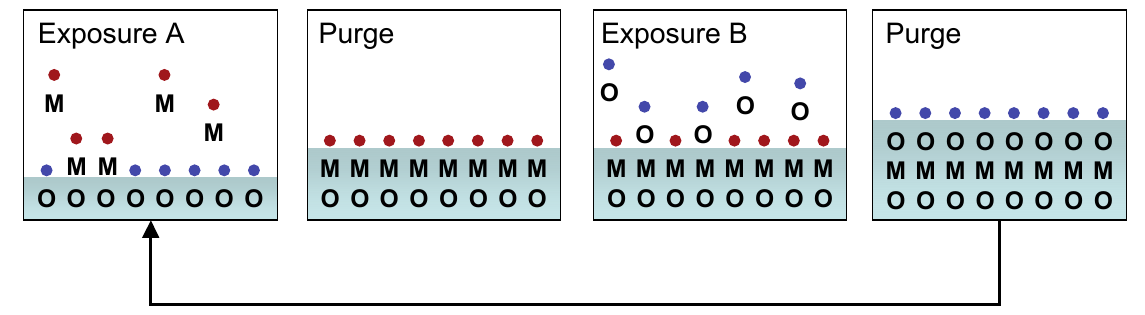
Figure 1. An idealized view of the atomic layer deposition (ALD) process